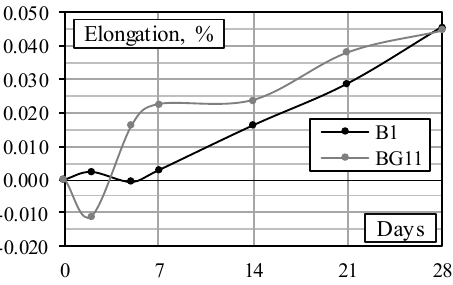
Figure 5. Expansion of specimens with sand (B1) and EGA (BG11).